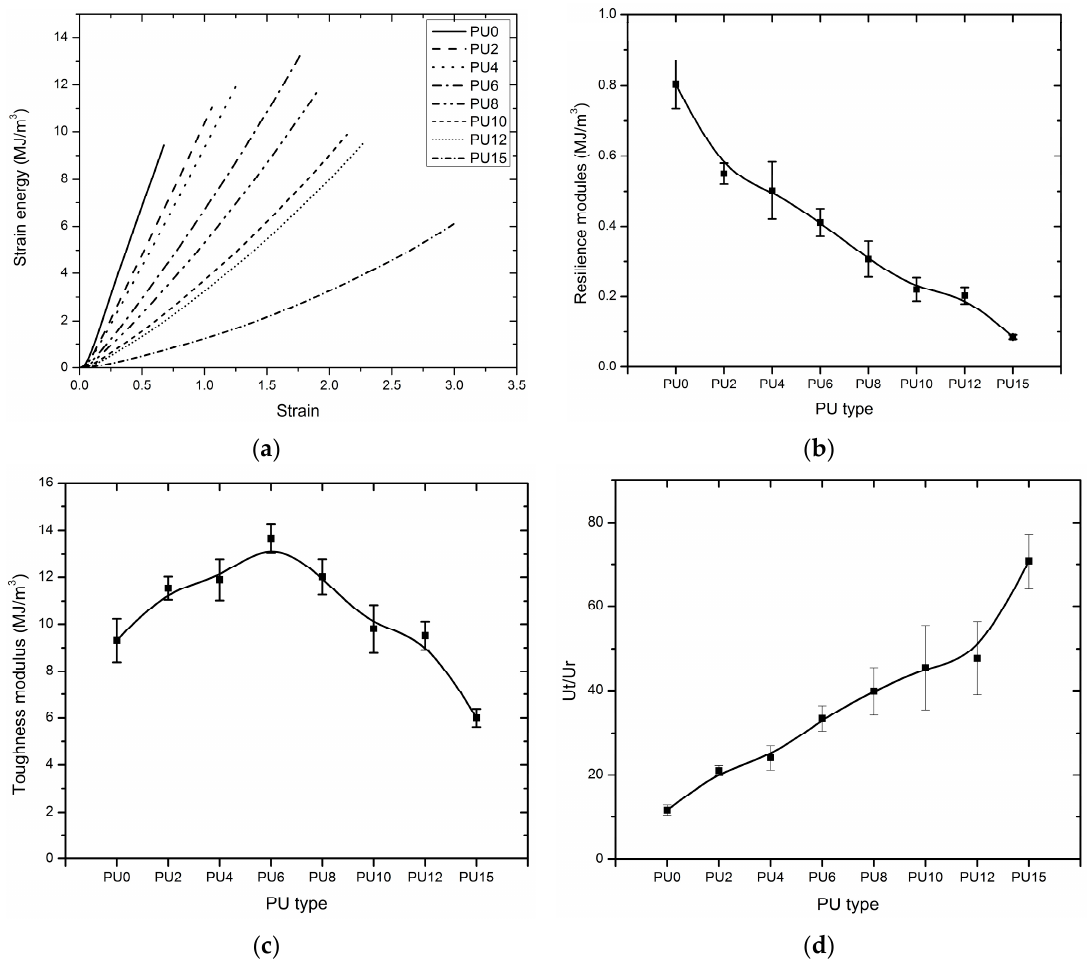
Figure 10. Comparison of strain energy of the PUs (PU0-PU15 are types of PU and PU6—PU which contain 6% PEG), ( a ) total strain energy vs. strain; ( b ) resilience modulus ( U r ); ( c ) toughness modulus ( U t ), ( d ) toughness to resilience modulus ratio ( U t / U r ).